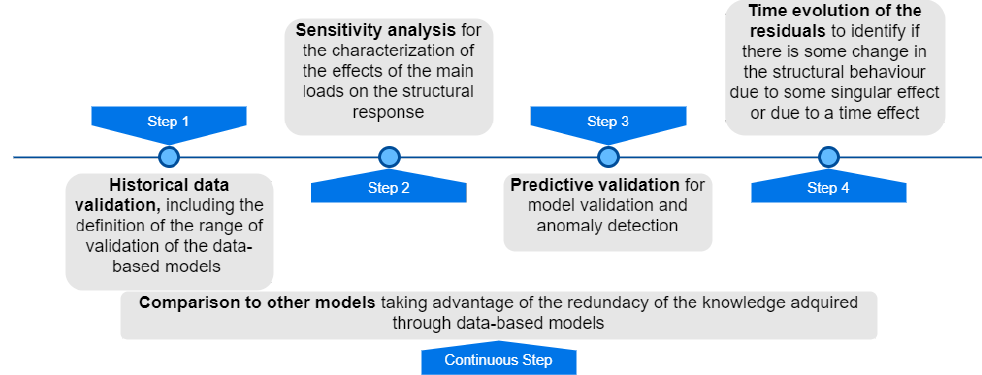
Figure 5. Proposed techniques for the verification and validation of ML models for dam behaviour interpretation. Table 2. Description of the proposed techniques for model validation and verification of ML models for dam behaviour interpretation, adapted from